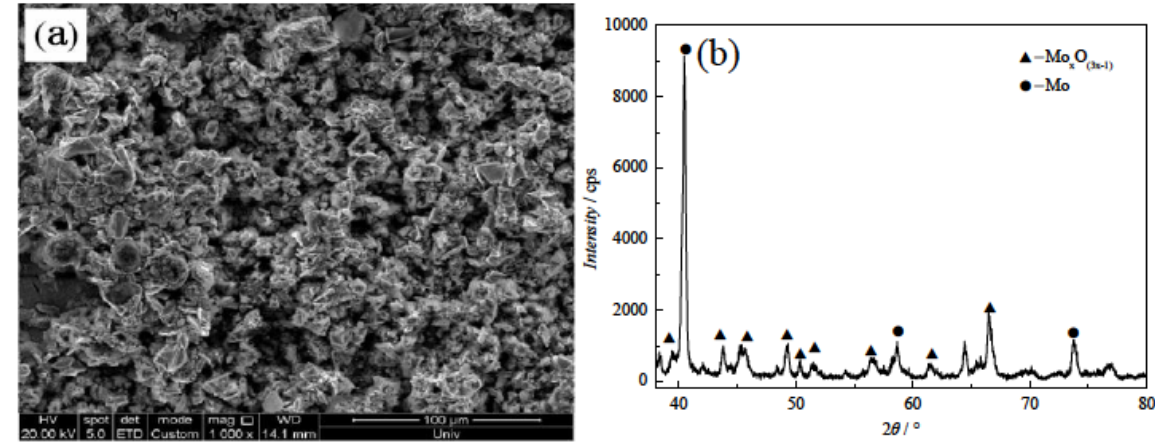
Figure 11: XRD of molybdenum electrodeposited layer